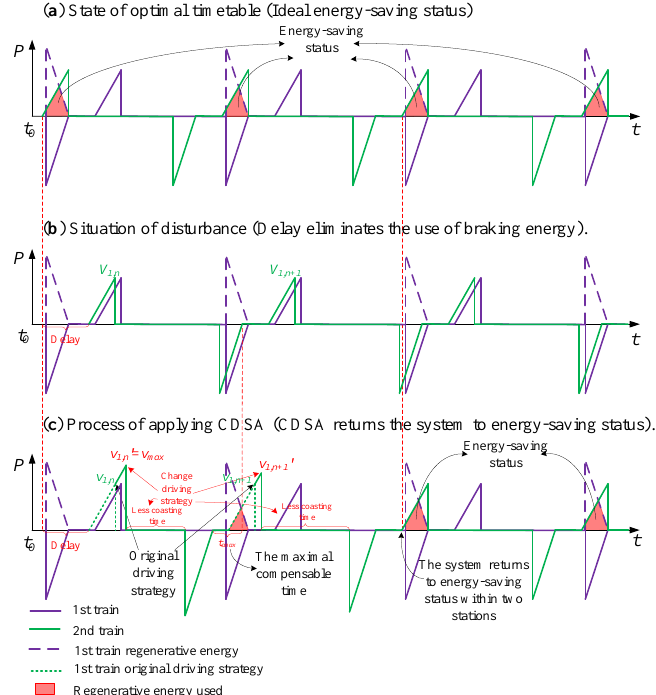
Figure 4. The mechanism of CDSA (Compensational Driving Strategy